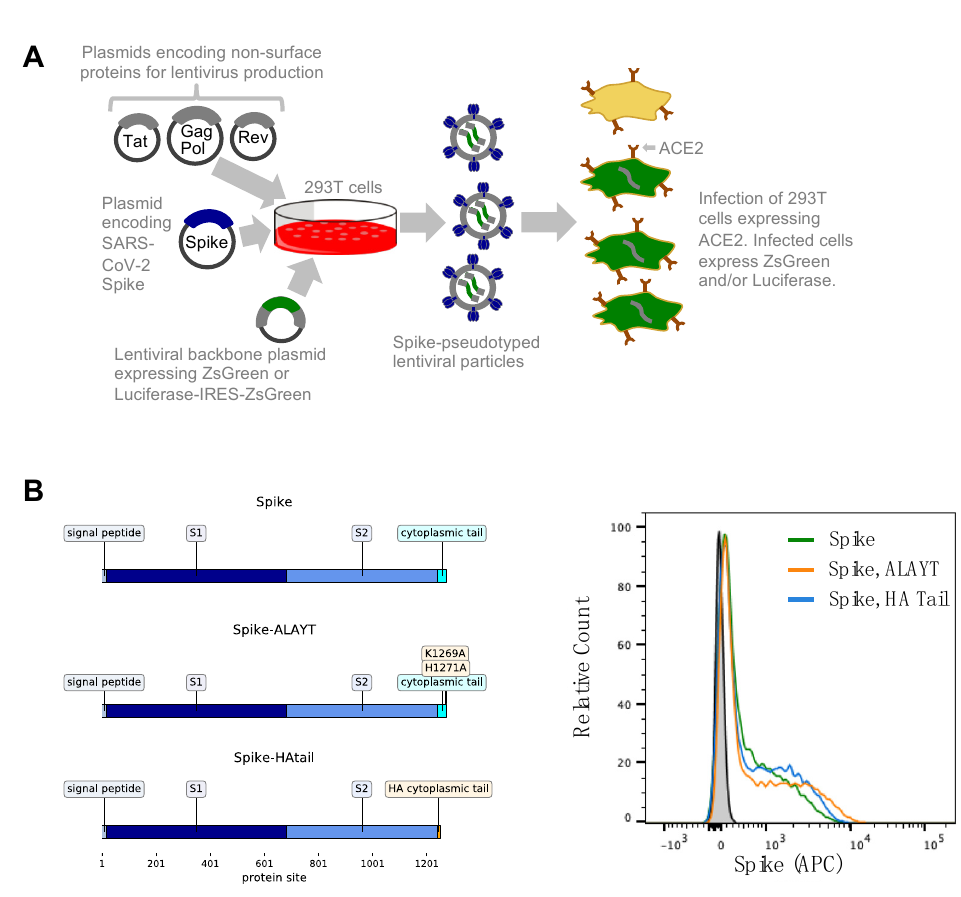
Figure 1. General approach for lentiviral pseudotyping. ( A ) 293T cells are transfected with a plasmid encoding a lentiviral backbone (genome) expressing a marker protein, a plasmid expressing Spike, and plasmids expressing the other HIV proteins needed for virion formation (Tat, Gag-Pol, and Rev). The transfected cells produce lentiviral particles with Spike on their surface. These viral particles can infect cells that express the ACE2 receptor. ( B ) We used three variants of Spike: The codon-optimized Spike from SARS-CoV-2 strain Wuhan-Hu-1, a variant containing mutations K1269A and H1271A in the cytoplasmic tail (such that the C-terminal five amino acids are ALAYT), and a variant in which the cytoplasmic tail of Spike has been replaced with that from influenza hemagglutinin (HA). ( C ) Spike expression on the surface of 293T cells transfected with the plasmids expressing our three Spike constructs was measured using flow cytometry 24 h post-transfection. Spike expression was measured by staining with in-house produced CR3022 antibody [43–45] at a concentration of 10 µ g / mL followed by staining with an anti-human Fc antibody conjugated to APC (Jackson Labs, 109-135-098) at a 1:100 dilution.